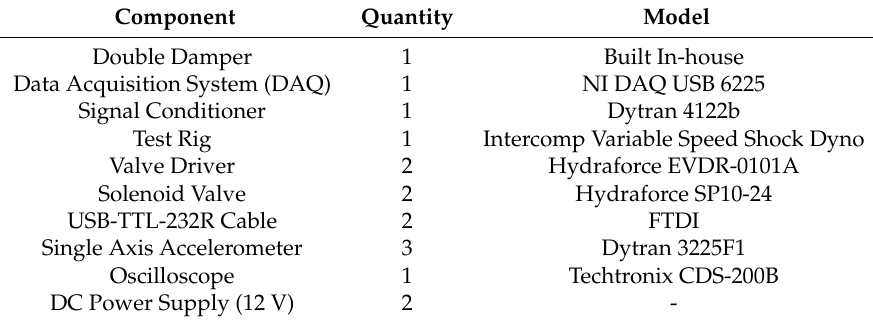
Table 1. Experimental